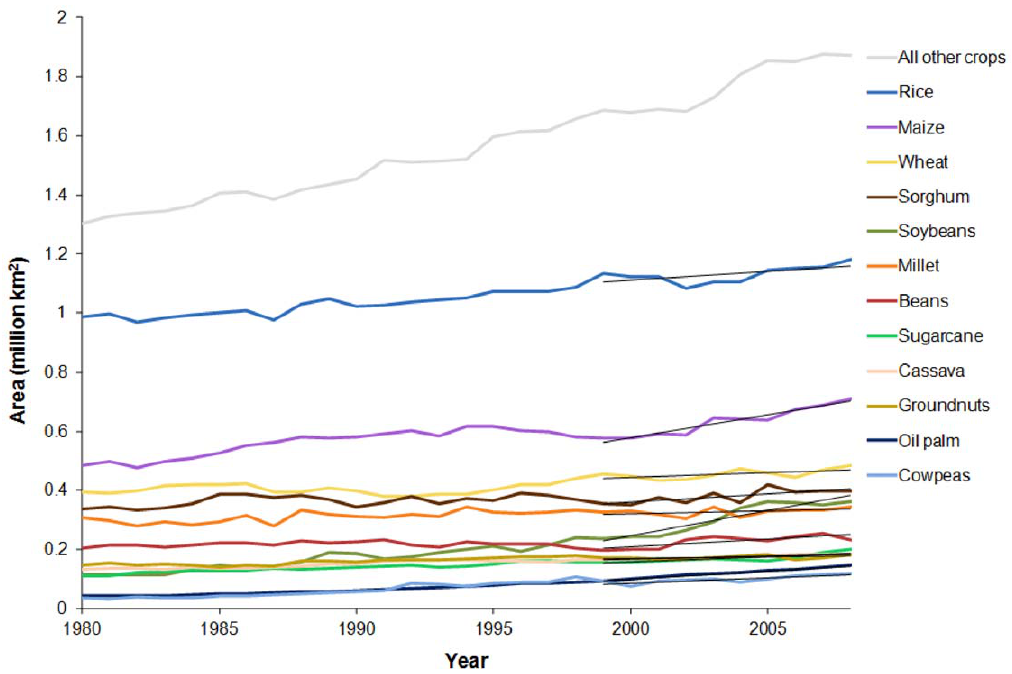
Figure 1. Harvested area of major crops in tropical countries, 1980–2008. The top ten crops in terms of their area in 2008 are shown. Oil palm and cow peas, which were the only two crops not on this list but which were in the top ten by area increase from 1999–2008, are also shown. Harvested areas of all other crops than these 12 are combined. Linear regressions used to assess recent rates of change in harvested area are shown. Source: [46].